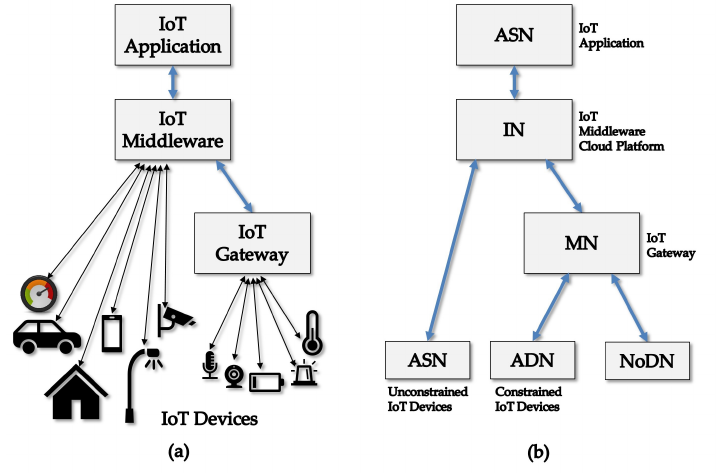
Figure 9. A common IoT Instance ( a ); and its corresponding oneM2M functional configuration ( b